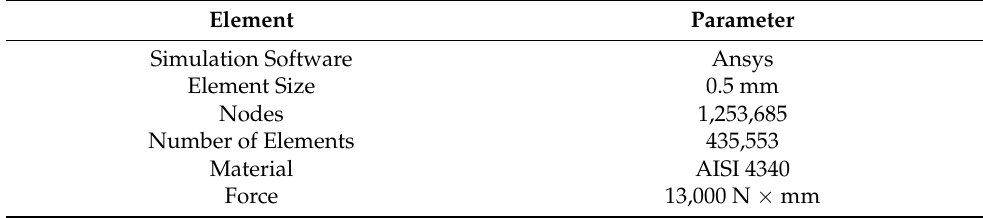
Figure 1. Rack and pinion assembly mesh and force. Table 6. Simulation parameters.